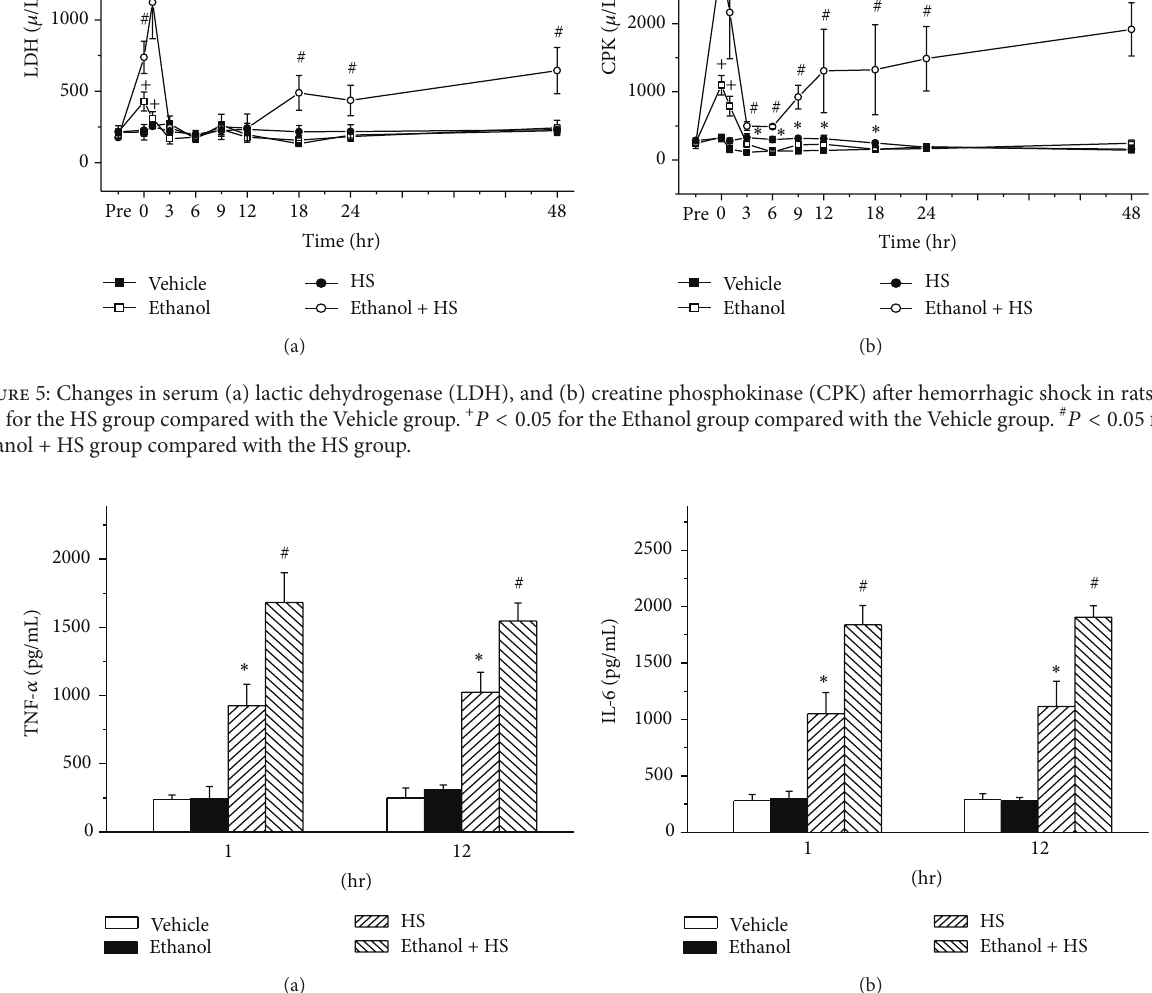
usually related to blood alcohol concentration. At a